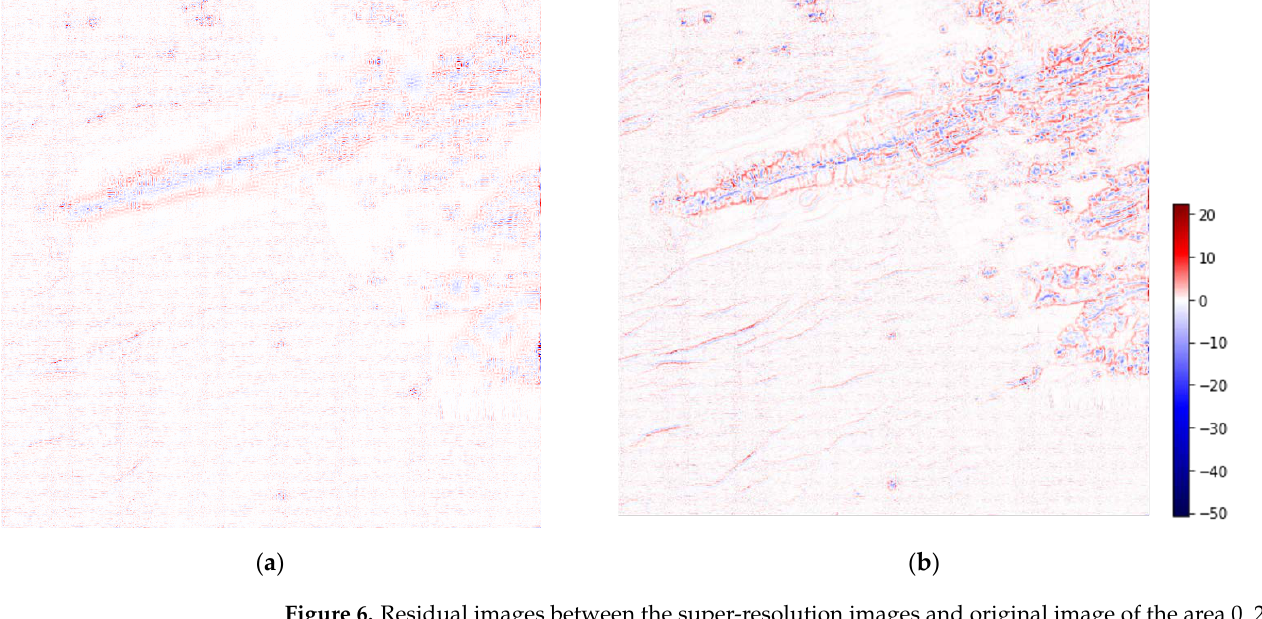
Figure 6. Residual images between the super-resolution images and original image of the area 0_2. ( a ) ScSR (RMSE: 1.157 m); ( b ) Bicubic interpolation (RMSE: 1.713 m). The same colour scale is used in both images. Table 1. RMSEs for eight regions reconstructed using the dictionaries learned in the other seven other sea areas, the RMSEs for bicubic interpolation, and their ratio. The unit of RMSE is metre in this table.